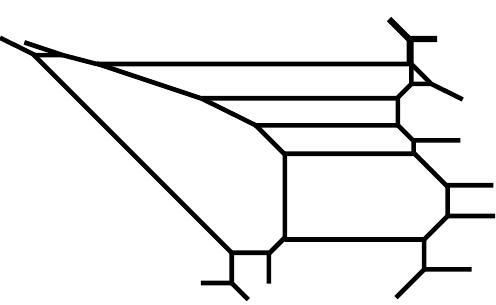
Figure 38 . The diagram obtained by deforming the diagram in (cid:12)gure 23. The diagram gives the [1 F ] (cid:0) SU(2) (cid:0) SU(5) 2 (cid:0) [5 F ; 1 AS ] quiver theory.